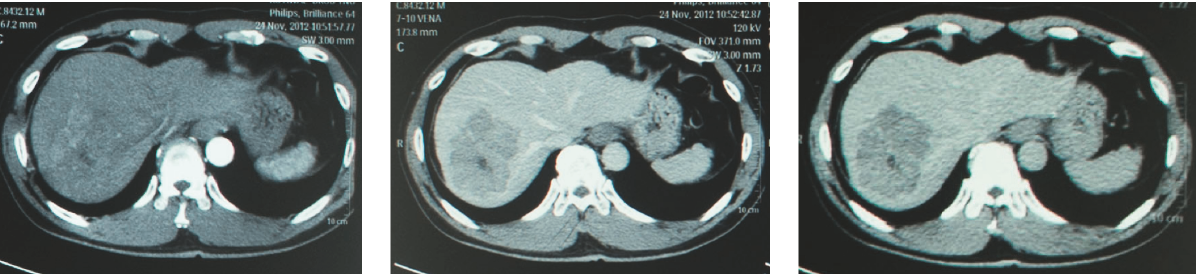
Figure 1: Arterial, venous, and delayed phase of Abdominal CT Scan after diagnosis (November 2012).